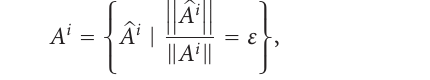
communication range. The interaction graph is based on a “closest spatial neighbors”